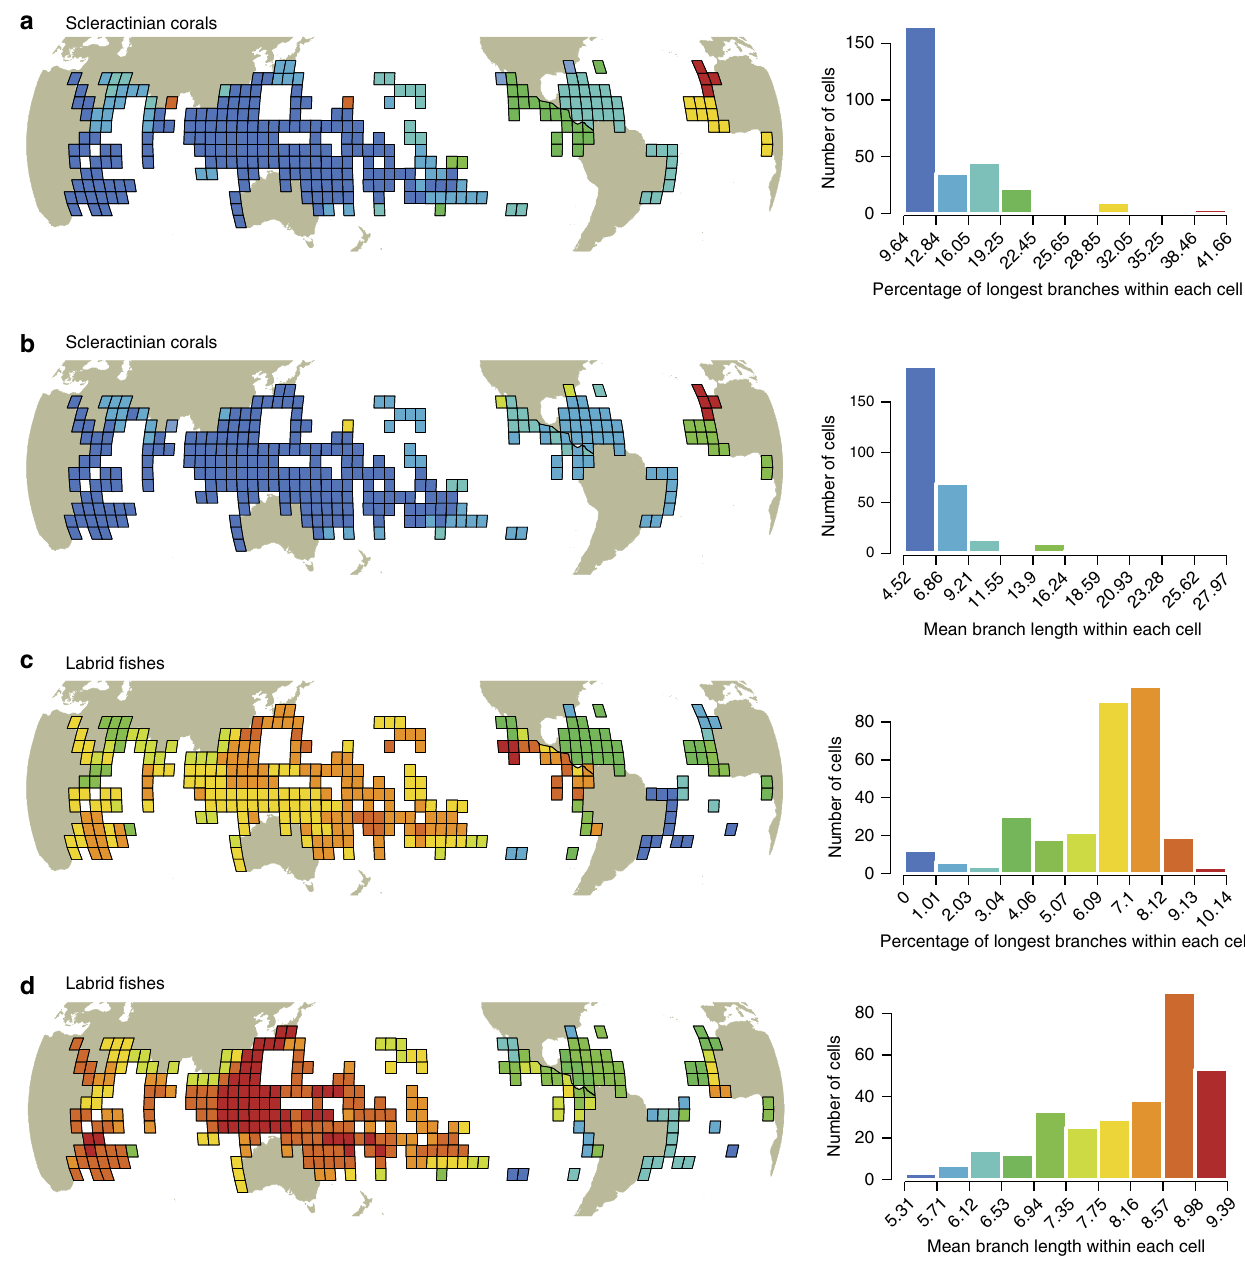
Figure 4 | Global distribution of the amount of evolutionary history on coral reefs. Global maps representing, for each grid cell (5 (cid:2) (cid:2) 5 (cid:2) ), the percentage of the longest evolutionary branches (top 10%) and the mean evolutionary branch length within coral ( a , b ) and fish ( c , d ) local assemblages, respectively. Colours correspond to classes of the histograms representing the distribution of values across the